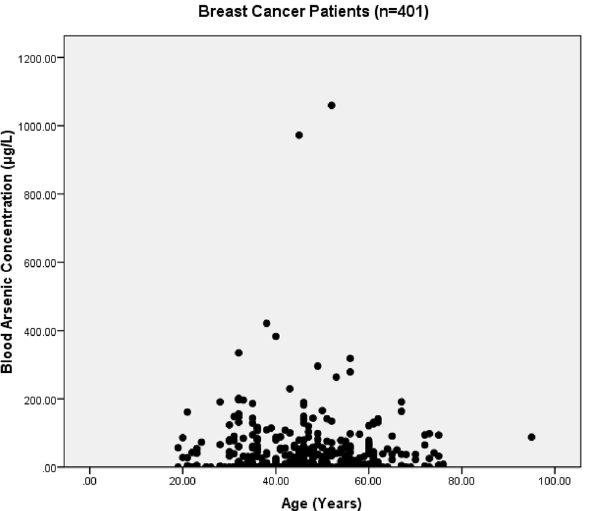
Figure 8. The correlation coefficient between blood arsenic levels and age of the female breast cancer patients (P < 0.05).